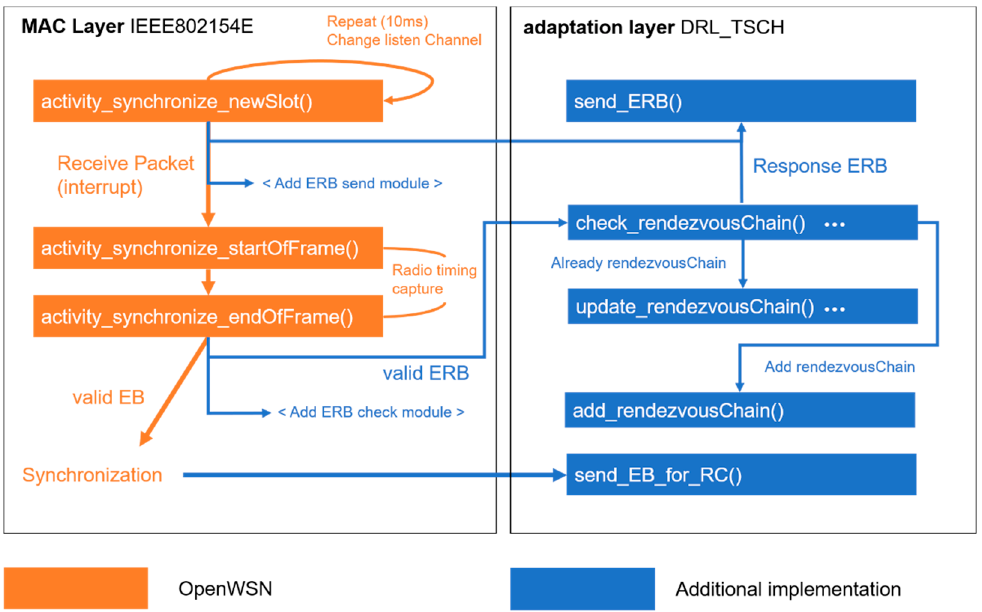
Figure 12 . Implementation of the paper's technique in OpenWSN.